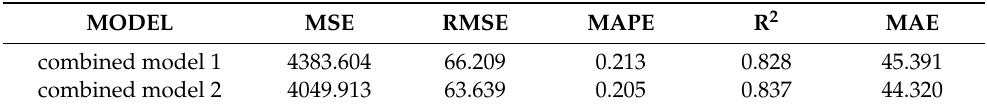
Table 3. Validation Metrics of the combined models.